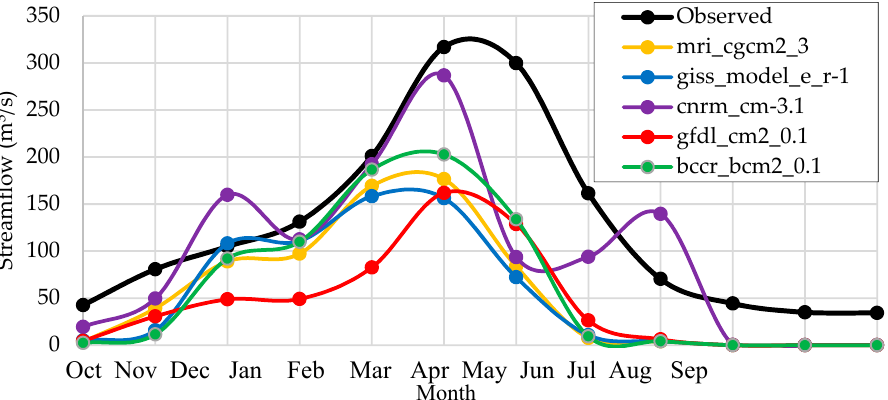
Figure 12. Impact of climate change on simulated streamflow of the Derbendkhan Watershed for the period from 2015 to 2050.